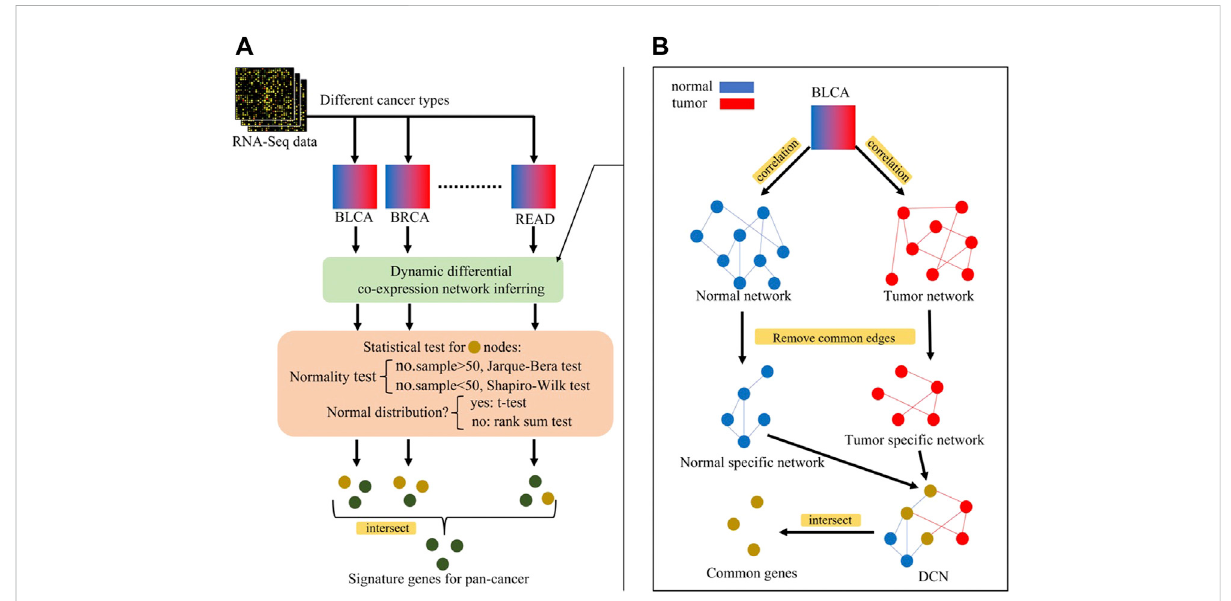
FIGURE 4 (A) Overview of identi fi cation process of signature genes for pan-cancer, (B) Inferring of differential co-expression network (DCN). Blue nodes representgenesinnormalnetwork,rednodesrepresentgenesintumornetwork,andyellownodesrepresentgenesinbothnetworks(intersection). Perform statistical tests on yellow nodes and green nodes represent statistically signi fi cant genes, i.e., signature genes for pan-cancer early-stage